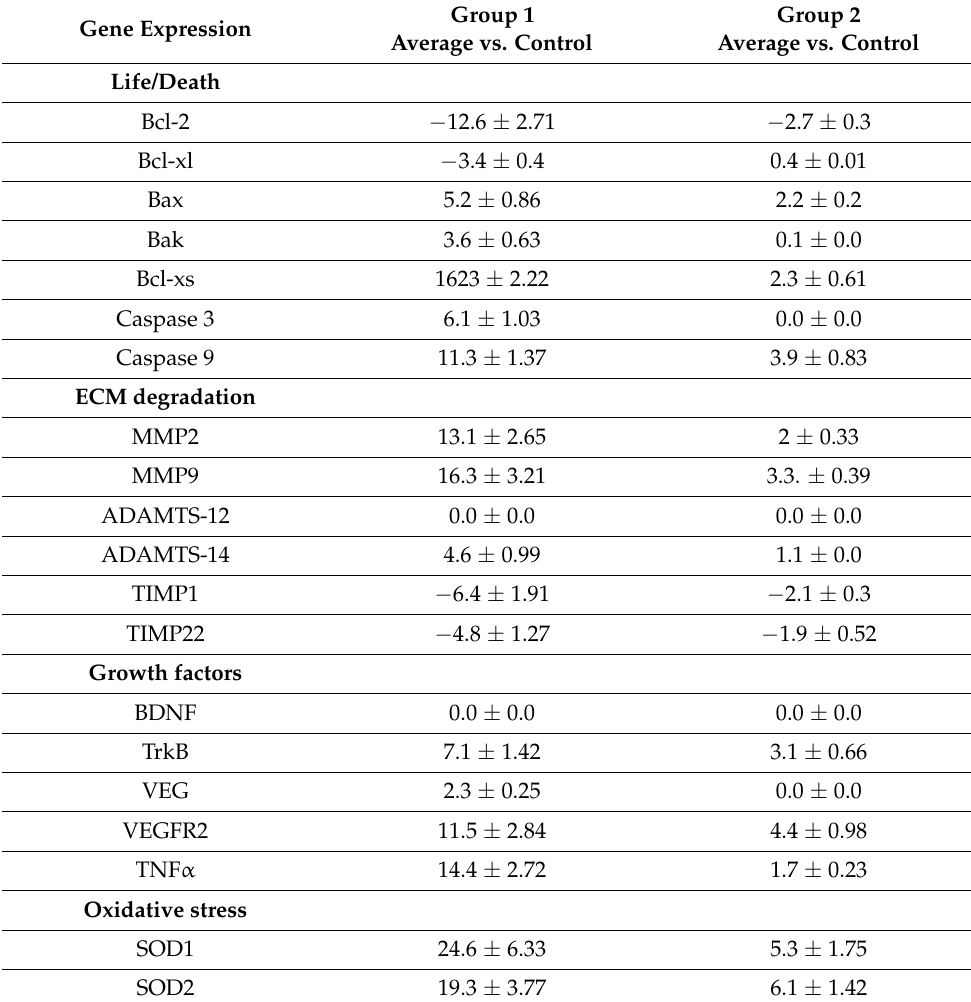
Table 3. Changes in the gene expression in the two established experimental groups in relation to the